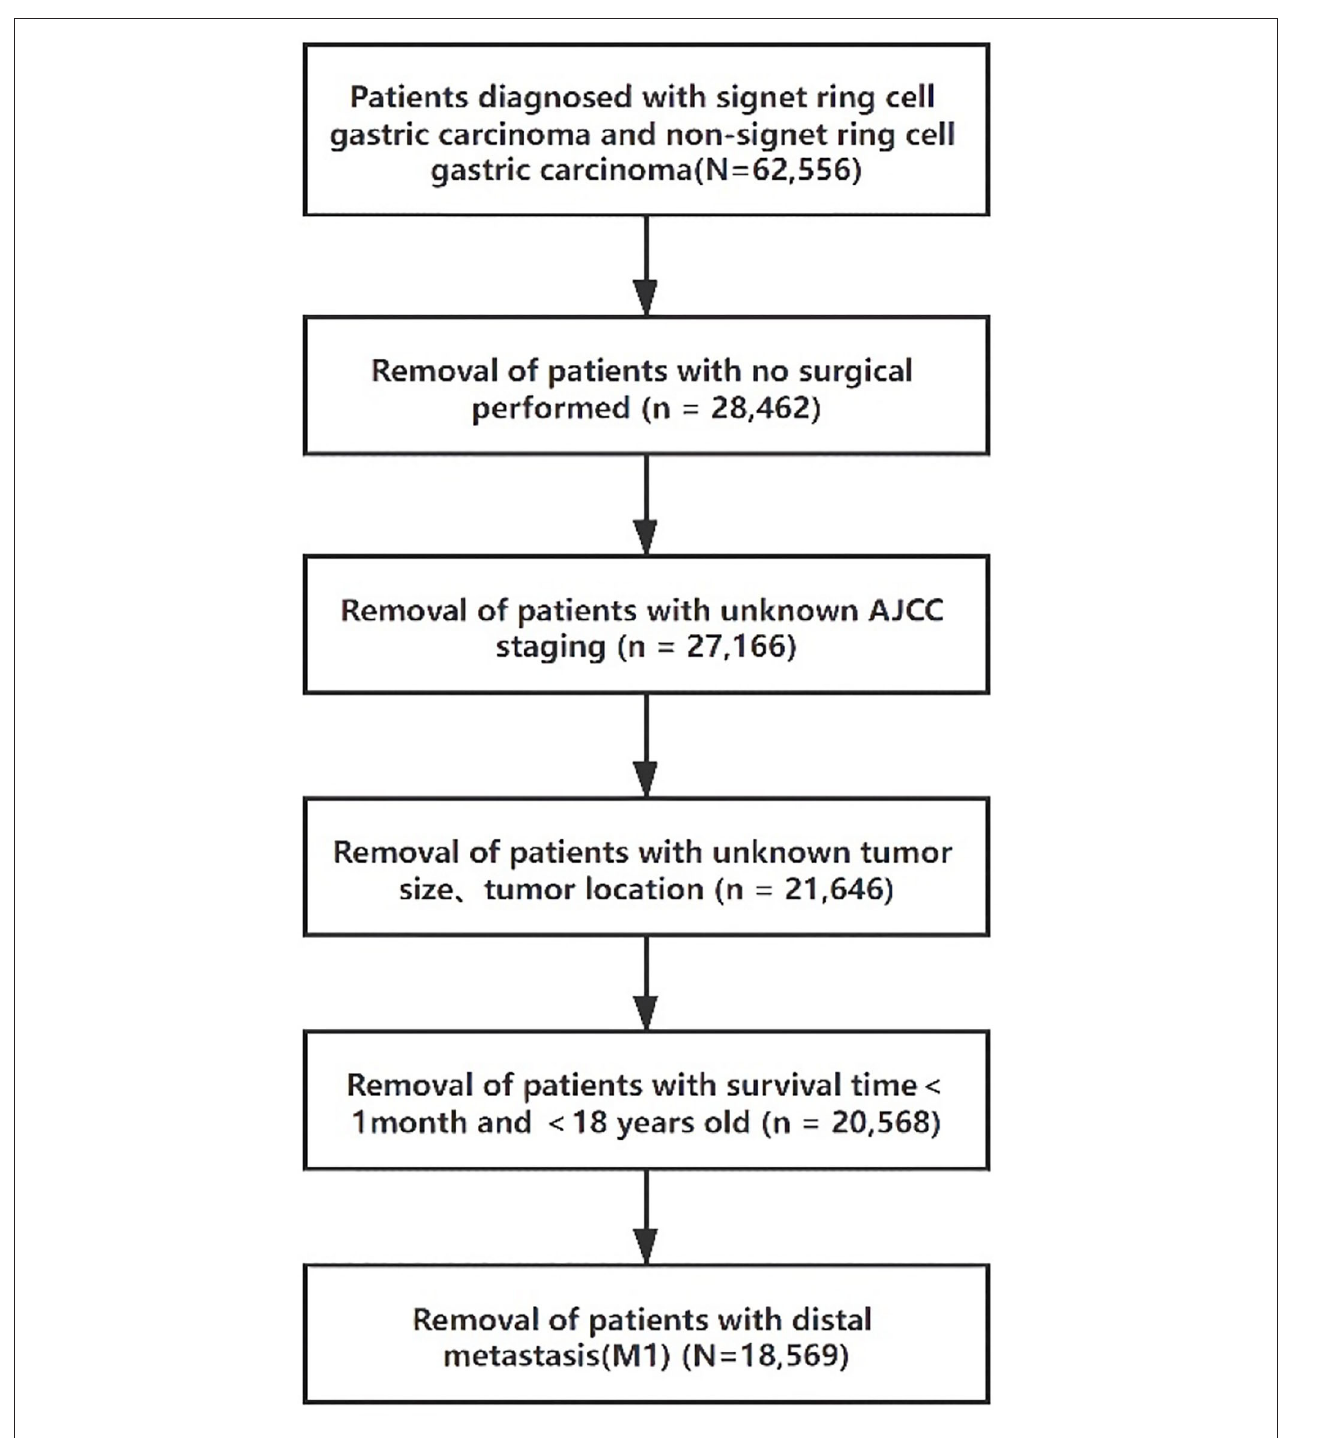
FIGURE 1 | Flow diagram of selected cases in the surveillance, epidemiology, and end results database.